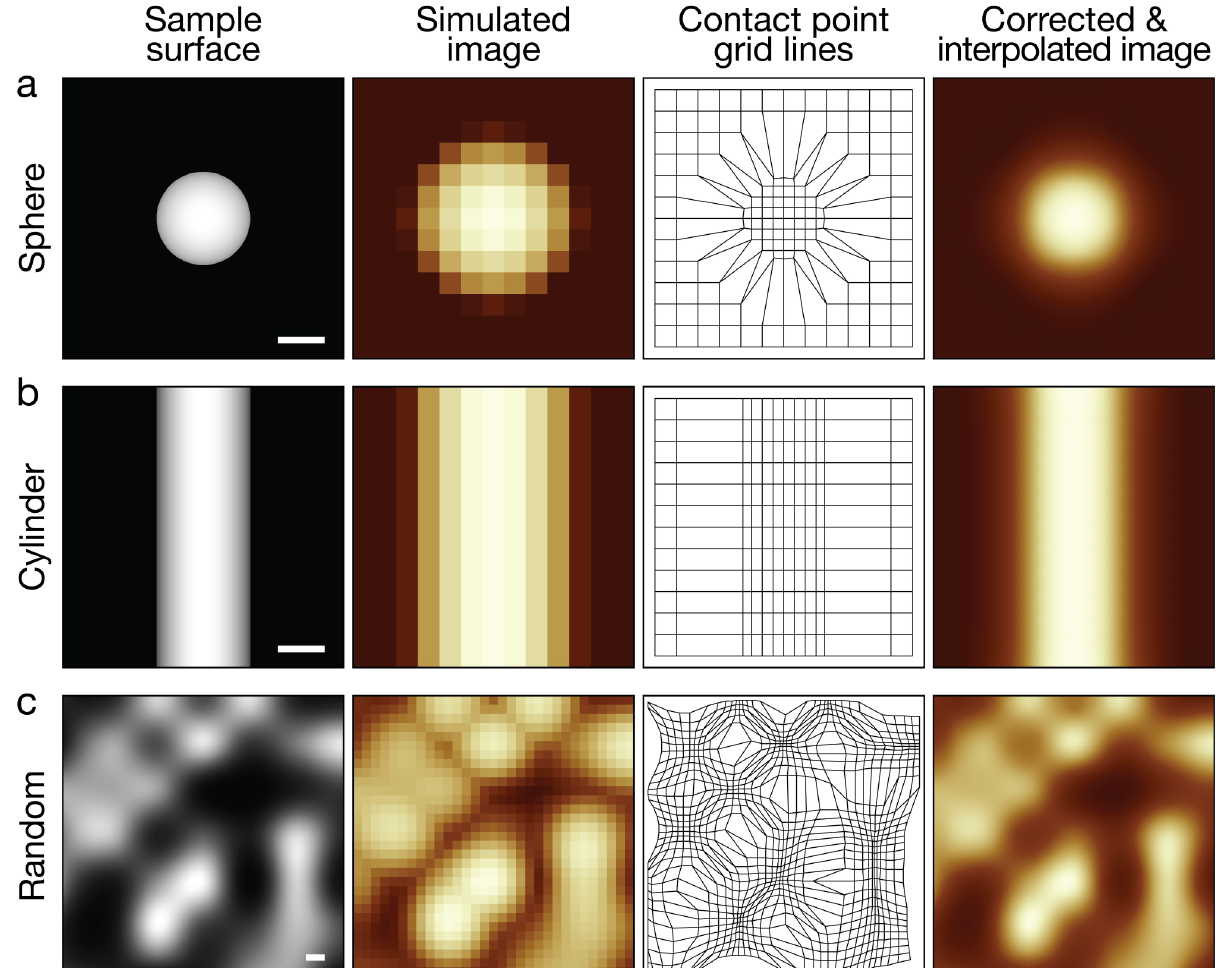
Figure 2: Contact-point deconvolution can be applied to any surface and results in increased local lateral sampling for upward convex sample features. Simulated AFM image (2nd column from left), shifted pixel grid lines after contact point deconvolution (3rd column from left) and a corrected image with contact points interpolated to a finer pixel grid (right most column) are shown for a sphere (a) , cylinder (b) , and a randomly generated surface (c) shown in the left-most column. The sphere and the cylinder both have a radius of 2 nm. A symmetric conical tip with a radius of 2 nm and tip side angle of 18° was used for all simulations. The scale bars represent 2